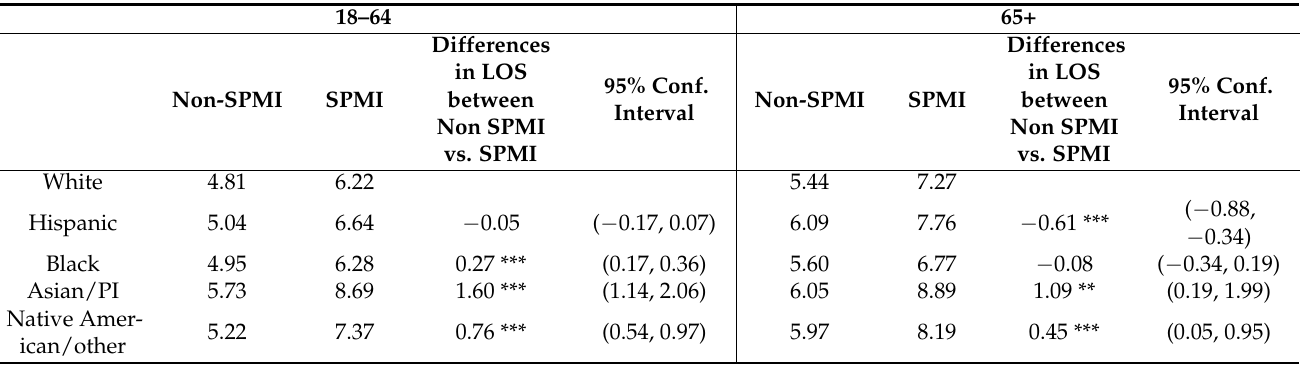
Table 3. Weighted Predicted Mean and Changes in Racial/Ethnic Differences in LOS between Patients with Non-SPMI vs. SPMI, by age